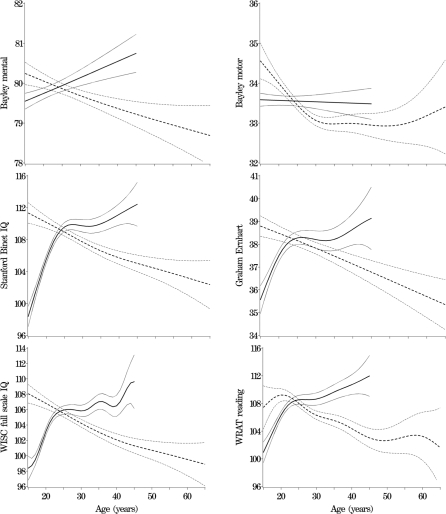
Primary Analyses: Model 1—Adjusted for Other Parent's Age, Mother's Race, Gestational Age, and Child GenderSolid lines ranging from 15 to 45 y for maternal age, dotted lines ranging from 15 to 65 y for paternal age. Nonlinear model fit with 95% CIs.